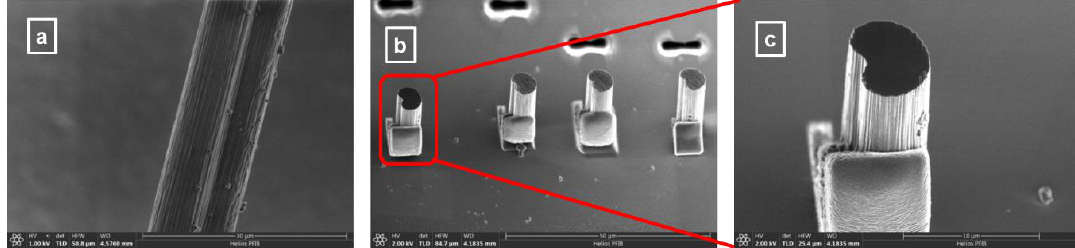
Figure 1. ( a – c ) Side view and cross-sectional SEM images of carbon fibers. For cross-sectional images mounting on Si substrates and fiber trimming were performed.